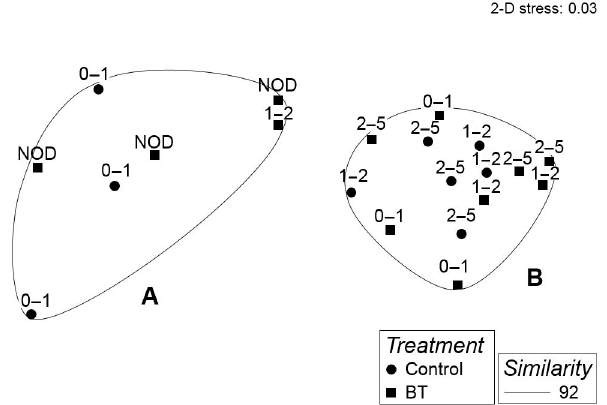
Figure 4. MDS plot of the meiobenthos community in each sample of the Control and Burial treatment (BT) per sediment depth layer with overlying contours of significant (SIMPROF test) clusters at a 92% similarity level indicated by the letters A and B. NOD is the crushed nodule particle